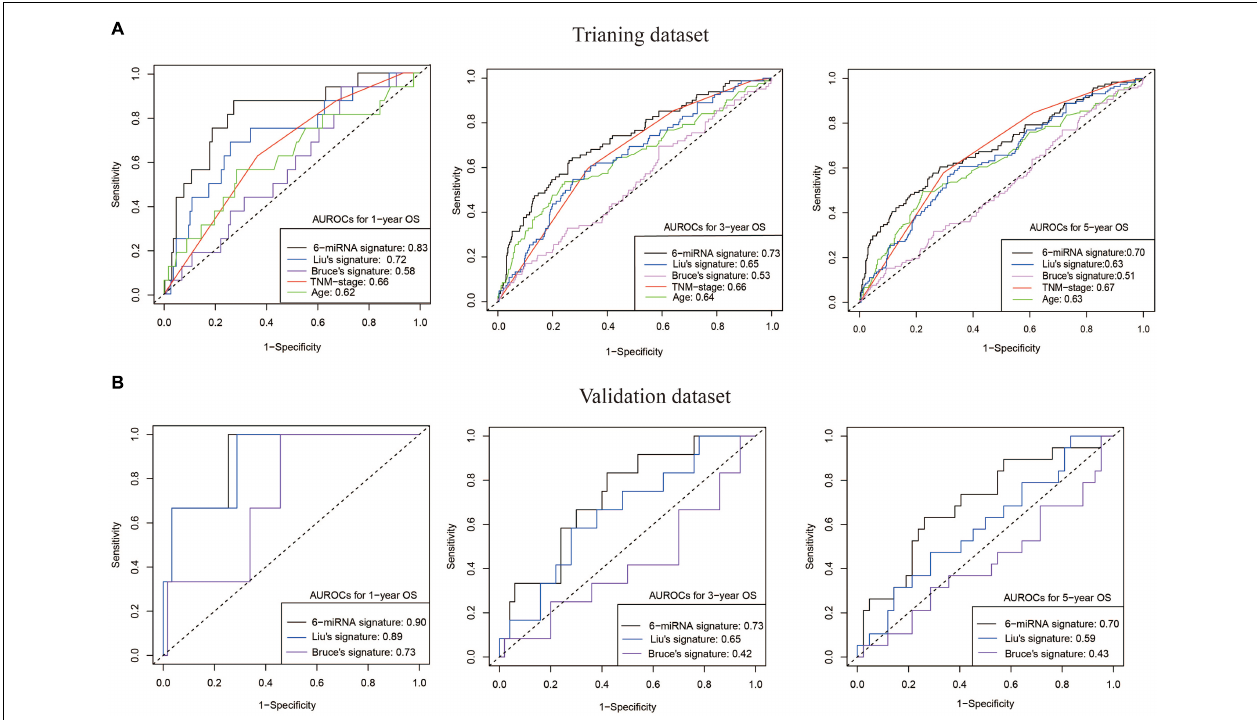
FIGURE 3 | Good OS prediction capability of our 6-miRNA signature model. (A) The AUCs of models built by our 6-miRNA signature, the 5-miRNA signature of Liu, the 4-miRNA signature of Bruce, and clinical variables (TNM stage and age) using the training dataset (558 patients). (B) The AUCs of models built by our 6-miRNA signature, the 5-miRNA signature of Liu, and the 4-miRNA signature of Bruce using the external validation dataset GSE36682 (62 patients). OS, overall